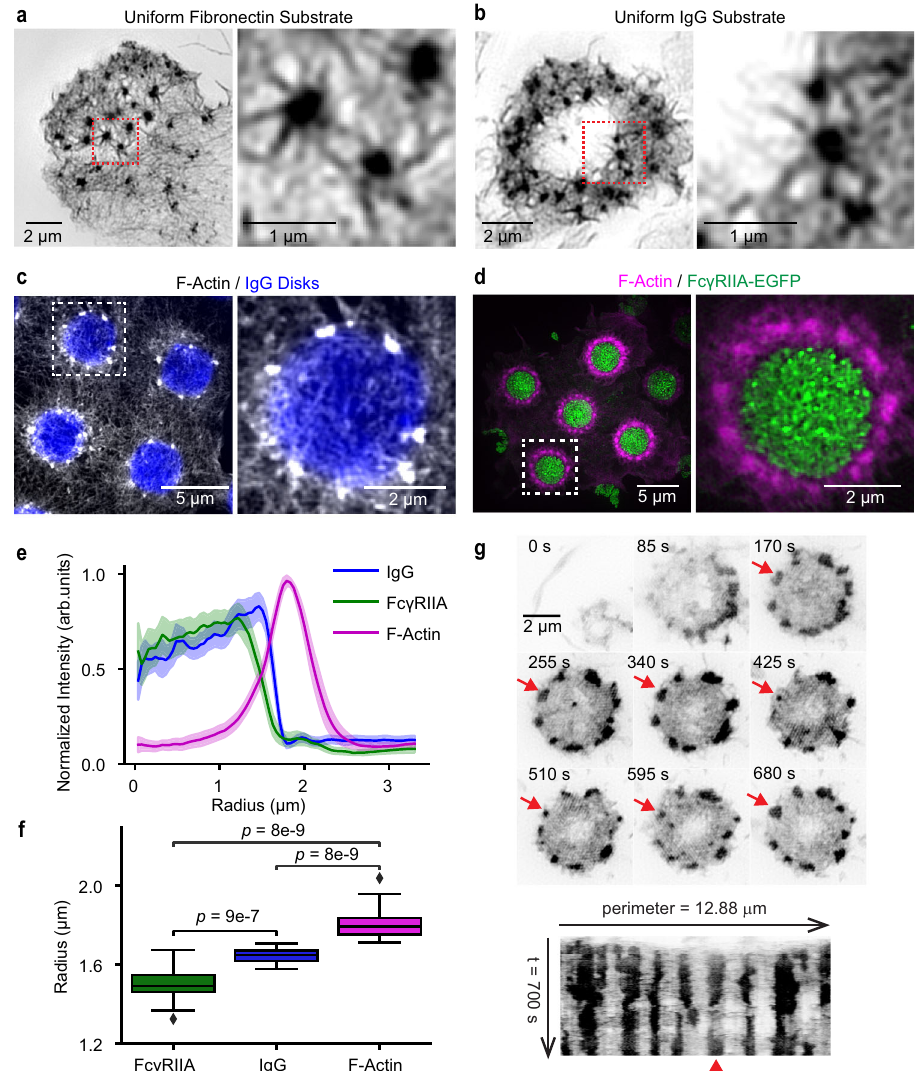
Fig. 1 | Podosomes on different substrates. a – d F-actin in RAW 267.4 cells. Enlargements show marked areas (dashed boxes). a =uniform fi bronectin (phal- loidin Alexa 568, SIM). b =uniform IgG (phalloidin Alexa 568, SIM). c =frustrated phagocytosisonmicropatterned IgGdisks,showingpodosomesorganizedaround the disk. (Lifeact-Halo549, IgG visualized with Alexa647 secondary antibody, TIRF- SIM). d =frustrated phagocytosis, showing the Fc γ RIIA receptor localized over the IgG disk, forming clusters (Lifeact-Halo 549, Fc γ RIIA-EGFP, TIRF-SIM). e Radial pro fi le of proteins from the center of IgG disks (data are presented as mean with